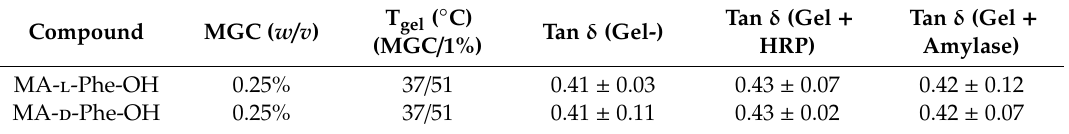
Table 1. MGC, T gel , and Tan δ (all at 1% ) values of hydrogels in 50 mM monobasic phosphate buffer at pH 7.